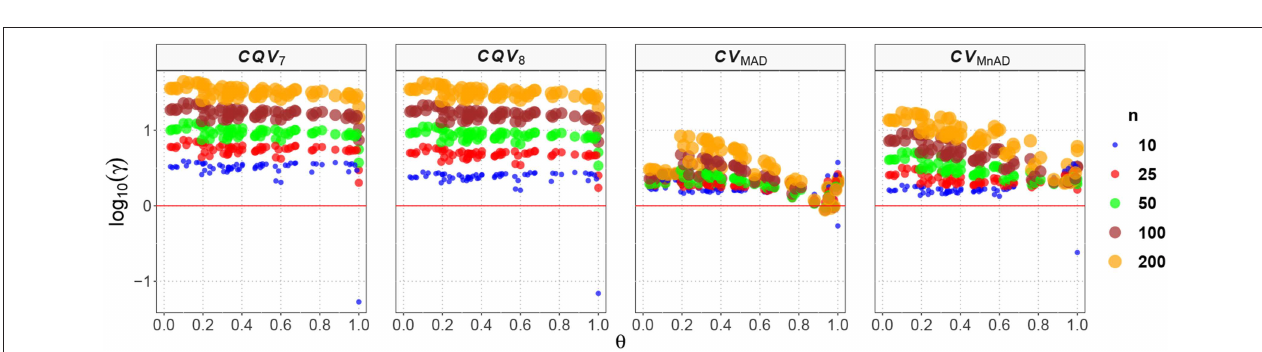
FIGURE 12 | Scatter plots comparing the log 10 ( γ ) accuracy metric as a function of θ Ex-Gaussian distribution.